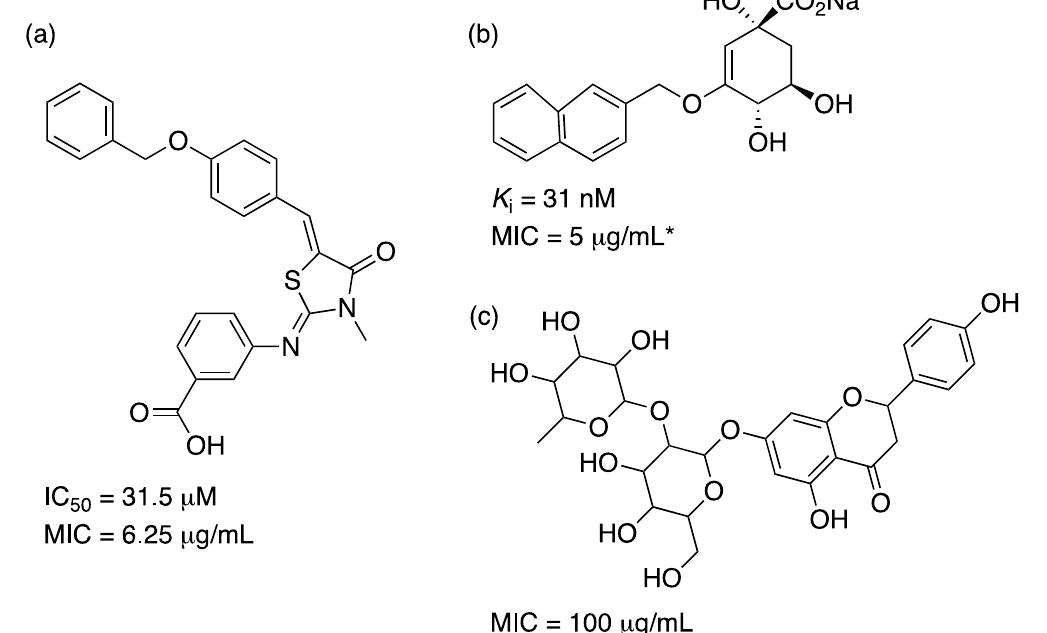
Figure 8. Structure of selected inhibitors of Mt DHQase. ( a ) Molecule generated by virtual screening extracted from Petersen and coworkers [69]. ( b ) Example of nanomolar competitive inhibitor extracted from Tizón and coworkers [79]. *MIC obtained with the n-propil ester prodrug. ( c ) Natural occurring molecule (Narigin) found by virtual screening by Lone and coworkers [81].